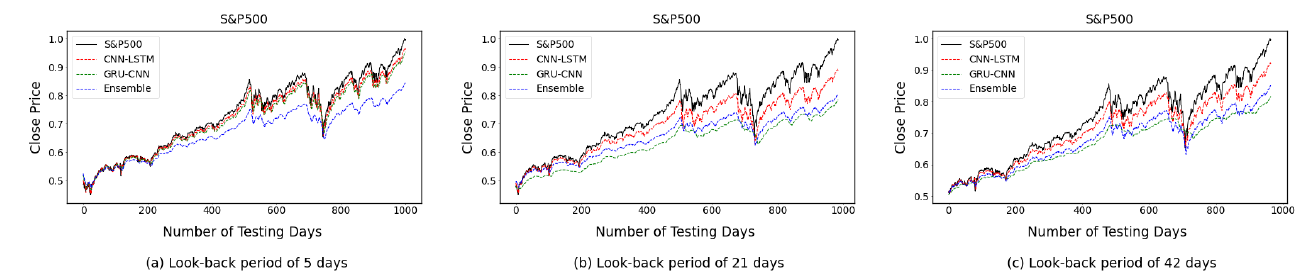
Figure 5. Comparison of true and predicted close prices of the S&P500 index between different look-back periods for one-time-step prediction over the period from 1 January 2000 through 31 December 2019.